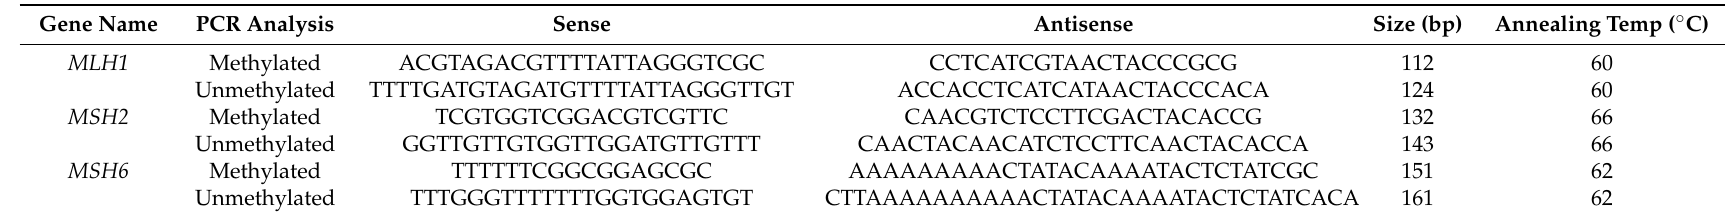
Table 2. Primer sequences used in methylation-specific polymerase chain reaction